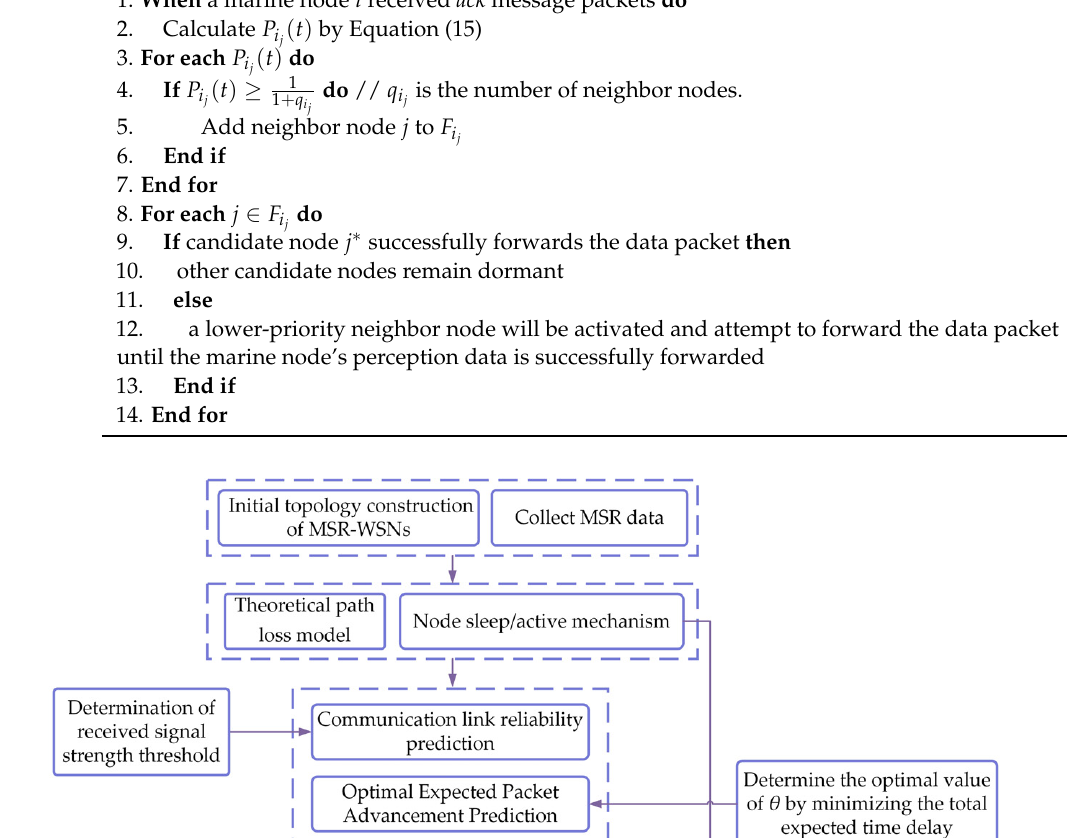
Algorithm 2 Scheduling of Candidate Forwarding Nodes